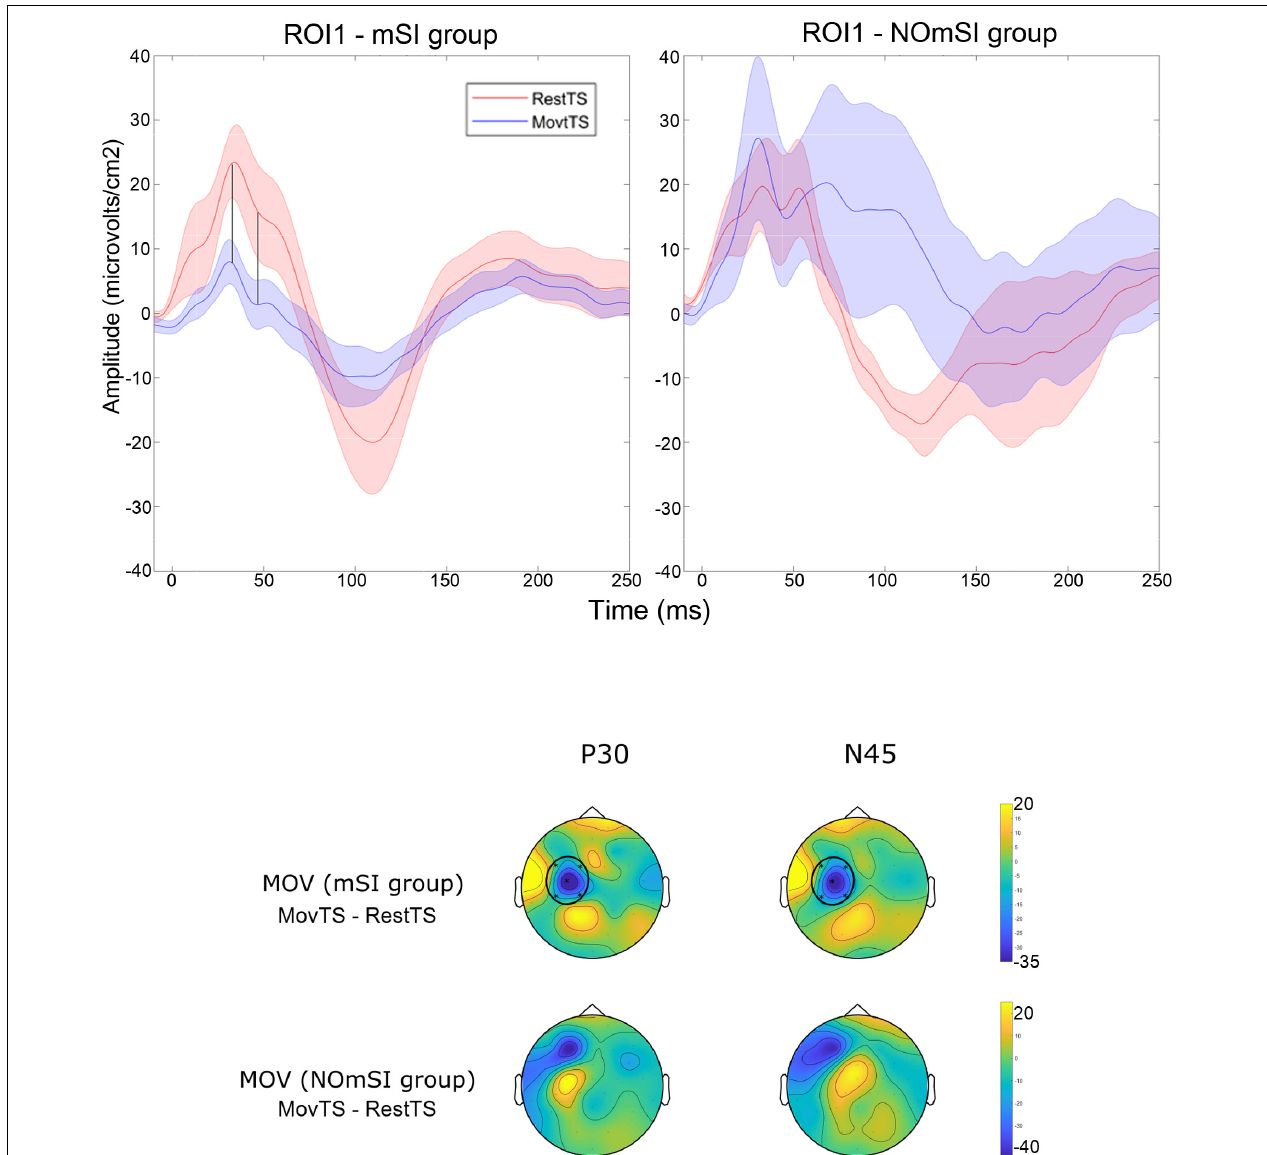
FIGURE 7 | Motor surround inhibition related modulation of TEPs. Upper panel: Averaged TEP in ROI1 at RestTS (red), MovtTS (blue) in the mSI group (left), and in the NOmSI group (right) (mean ± SE). In ROI1, P30 and N45 were modulated at movement onset only in the mSI group (vertical lines). Lower panel: topographic representation of current source density (CSD) for the effect of movement onset (MOV, expressed as MovTS – RestTS) on P30 and N45 in the group with (first row), and without mSI (second row), ROIs significantly modulated by MOV are highlighted (yellow, positive values; blue, negative